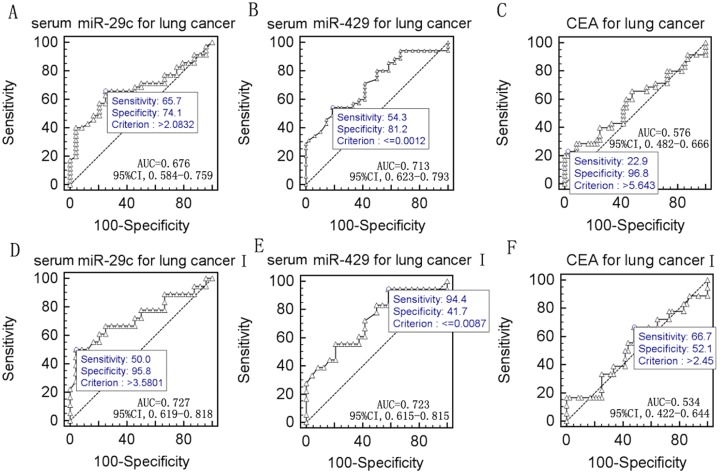
ROC curves for serum miRNA and CEA levels in NSCLC patients.A, miR-29c; B, miR-429; C, CEA showed ROC curves and an AUC with diagnostic power to distinguish NSCLC patients from healthy controls. D, miR-29c; E, miR-429; F, CEA showed ROC curves and an AUC with diagnostic power to distinguish stage I NSCLC patients from healthy controls.